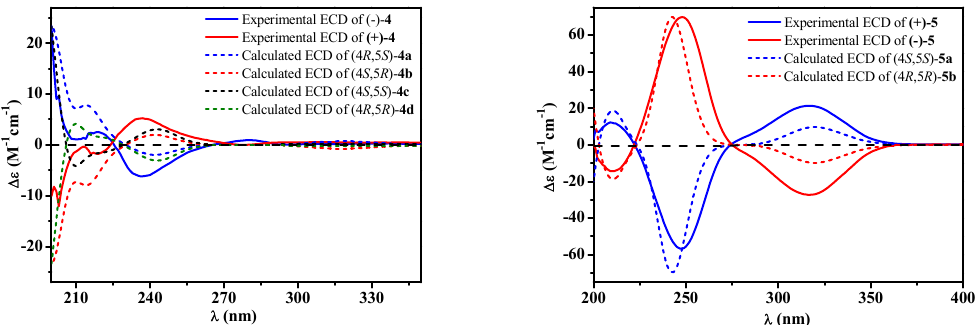
Figure 3. Experimental [( + ) / (–)- 4 , ( + ) / (–)- 5 ] and calculated [ 4a , 4b , 4c , 4d , 5a and 5b ] electronic circular dichroism (ECD) spectra.